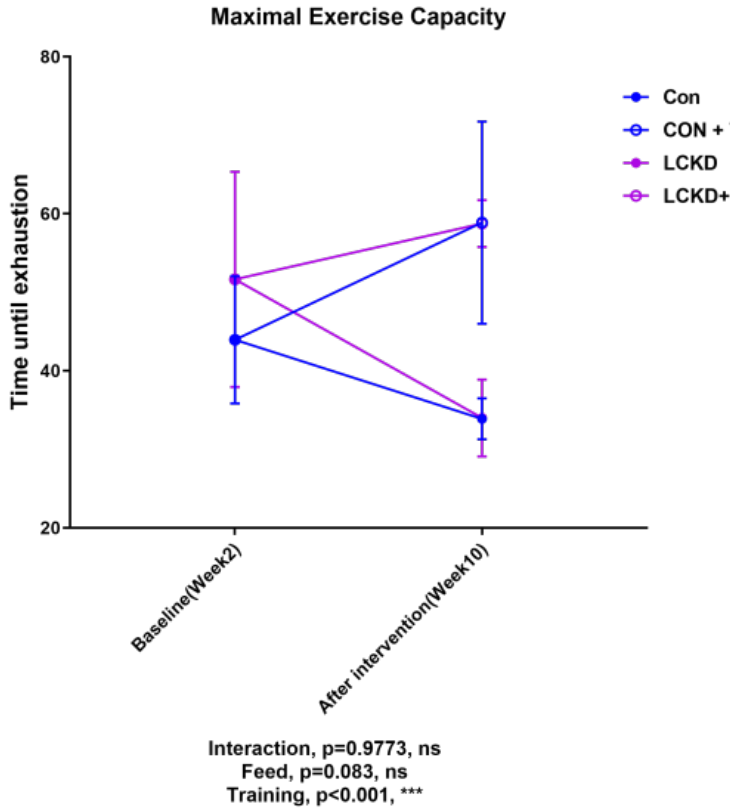
Figure 4. Maximal exercise capacity. Interaction refers to the interactive effect between diet and training. Con, Con + T, LCKD, and LCKD + T stand for chow diet, chow diet plus training, low-carbohydrate ketogenic diet, and low-carbohydrate ketogenic diet plus training, respectively. Feed indicates a main effect of diet, training indicates a main effect of treadmill exercise, and interaction indicates the interactive effect between feed and training. ns, no significance observed. *** p < 0.001. A two-way analysis of variance (ANOVA) was performed to determine the effects of diet, training, and interaction. When ANOVA indicated a significant effect, a Tukey’s post hoc test was performed to determine the significance of differences between means. Statistical significance was set at p < 0.05. Data are presented as the mean ± standard deviation (SD). n = 8 for each group.